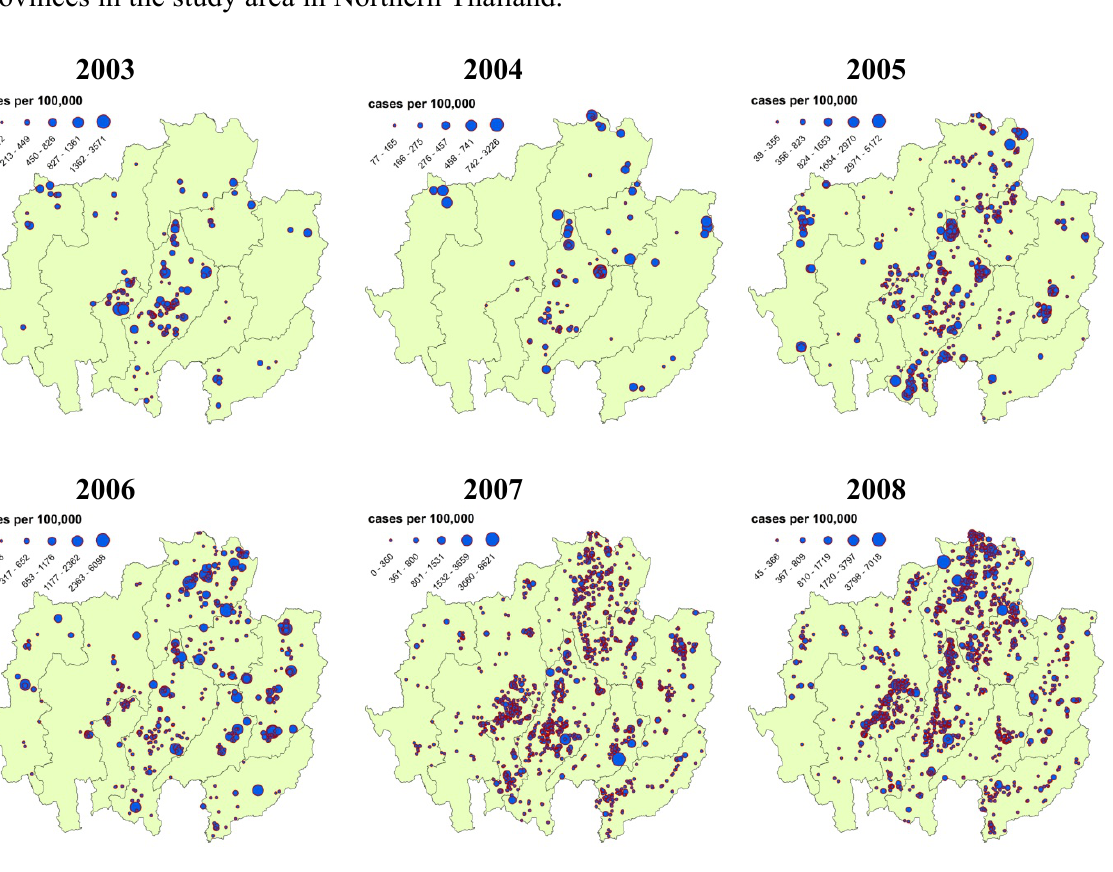
Figure 6. Annual HFMD incidence rates (2003–2012) and population density of the provinces in the study area in Northern